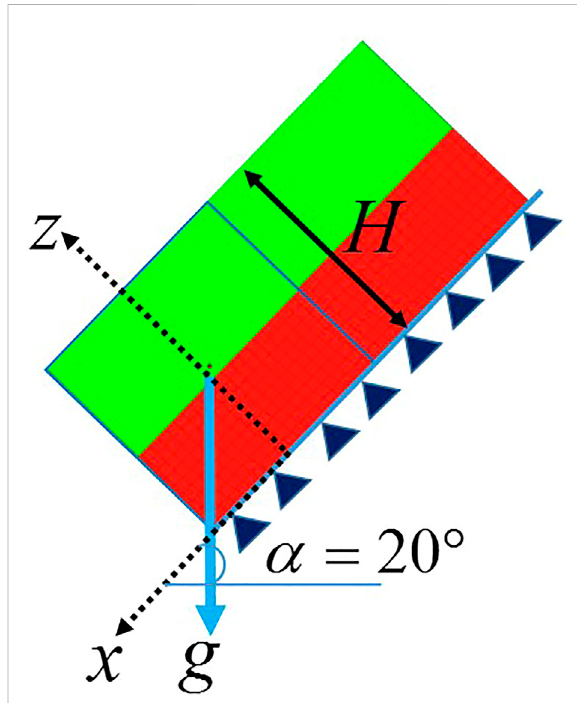
Flow of in fi nite layer under gravity on a slope. The green (resp. red) area represents the plug (resp. sheared) layer in the steady solution, as computed with the EVPHB